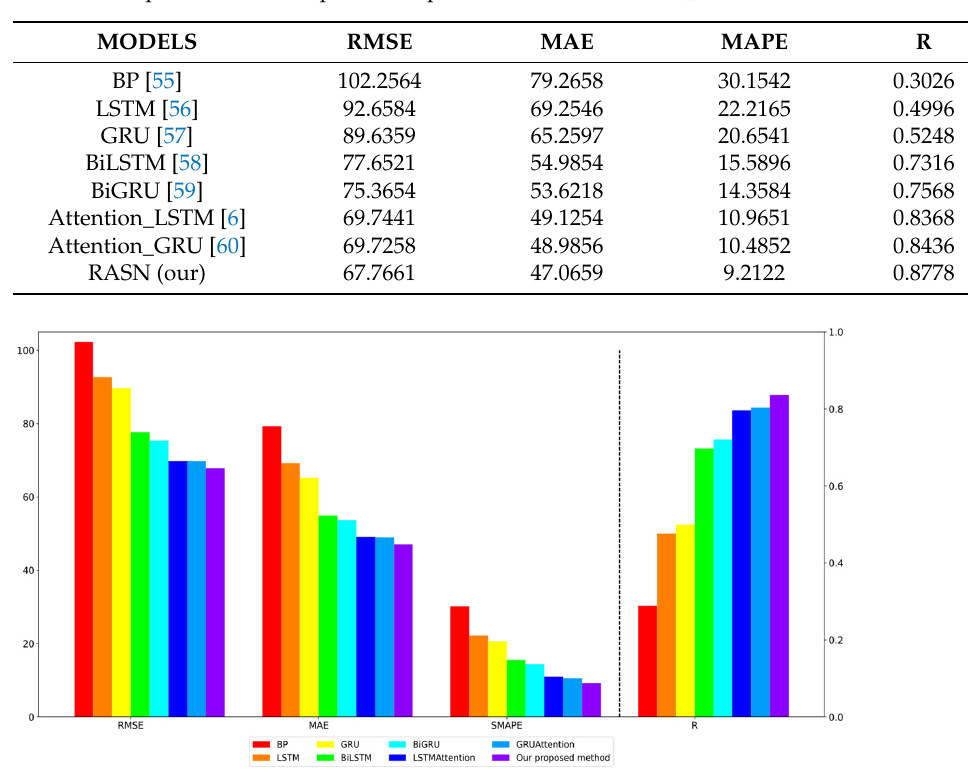
Figure 10. Comparison of evaluation indexes of the model based on CO 2 data.